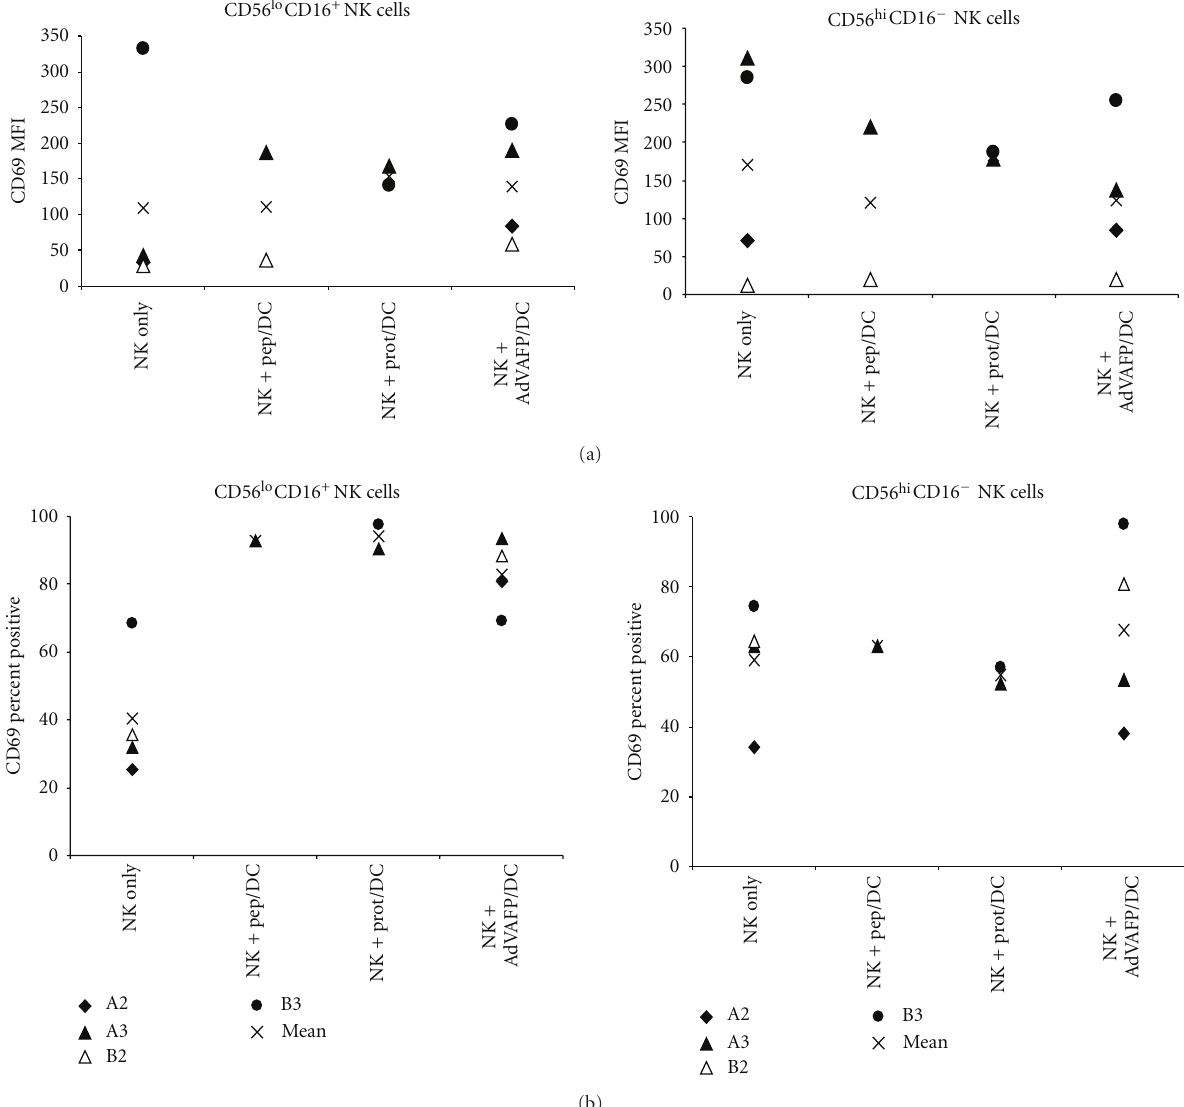
Figure 4: CD69 expression on HCC patient NK cells. Phenotyping of NK cells from HCC patients after 48hr coculture with di ff erent groups of DC, showing CD69 upregulation on CD56 hi CD16 − and CD56 lo CD16 + subtypes, by MFI (a) and percent positivity